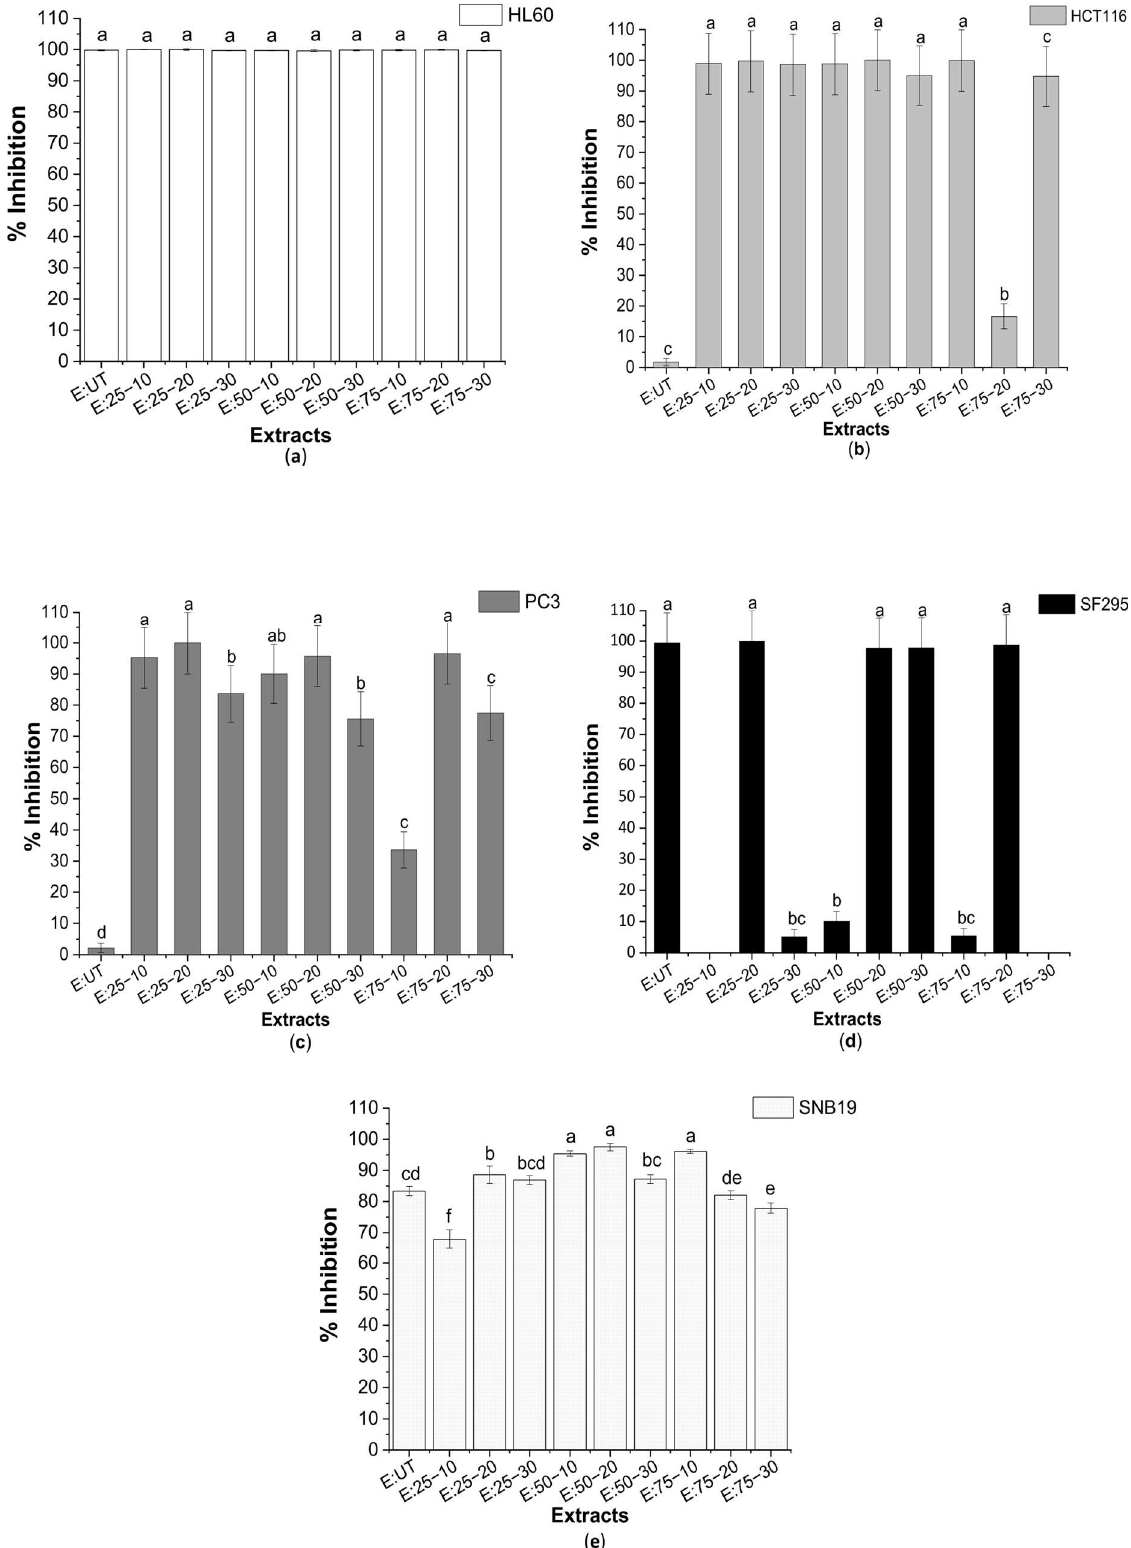
Figure 4. Percent growth inhibition of tumor cell lines ( a ) HL-60 (leukemia), ( b ) HCT-116 (colon carcinoma), ( c ) PC3 (prostate carcinoma), ( d ) SF295 (glioblastoma), and ( e ) SNB19 (glioblastoma) by red propolis extracts obtained under different conditions. Values with the same letter in the same analysis do not show significant differences ( p > 0.05) under Tukey’s test at 95% confidence. Average of analyses obtained from triplicates ( n = 3).